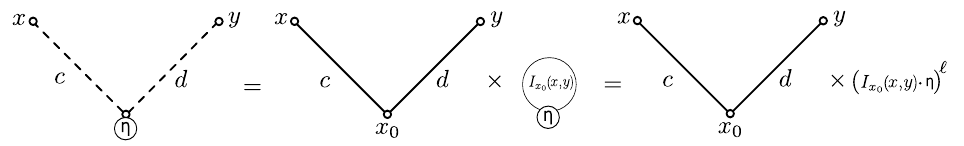
Figure 3 . Solid lines stand for the usual Feynman diagram notation, that is the square distance of the type ( x − y ) 2 between the extremal points x and y , to some power which is written adjacent to the line. Dashed line notation is illustrated in terms of product of solid lines and a tensor structure. µ − x µ µ − x µ The tensor I µ ( x, y ) = x − y is obtained by a conformal inversion around the point x 0 0 0 x 0 ( x − x 0 ) 2 ( y − x 0 ) 2 of the vector x µ − y µ .